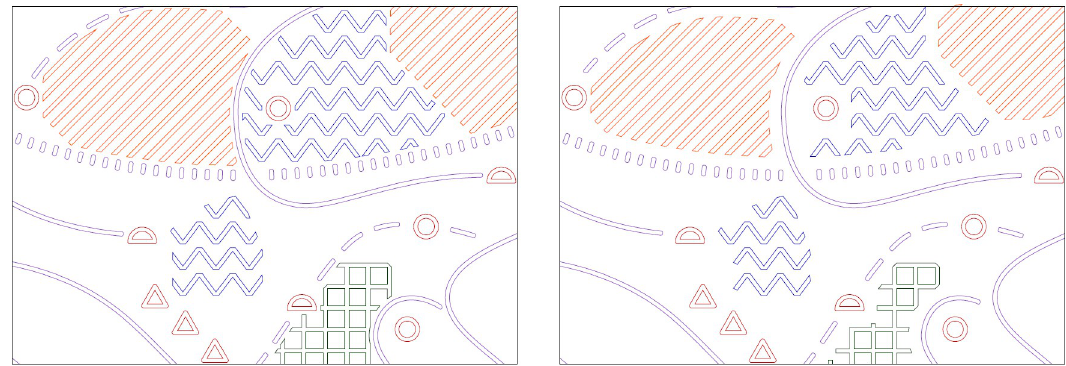
Fig 4. The increase of free space that can be filled with tactile symbols when reducing minimum distances between